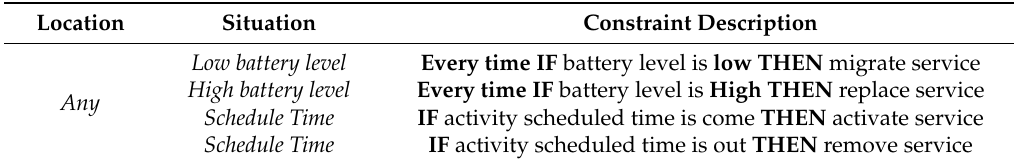
Table 4. Constraints specified by the developer.